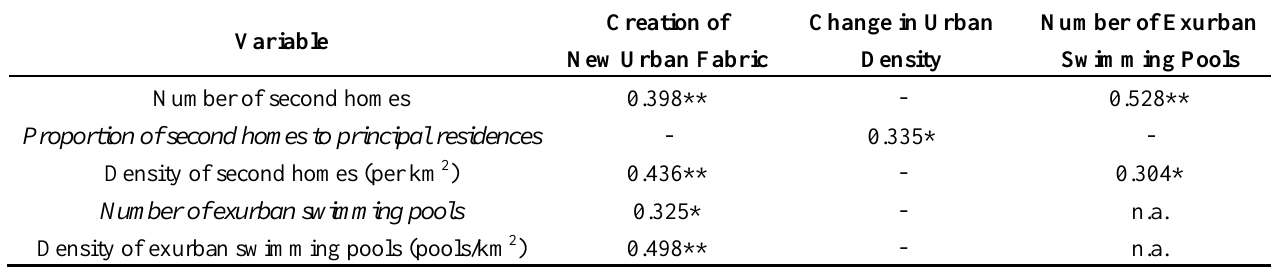
Table 1. Correlation matrix between urban sprawl